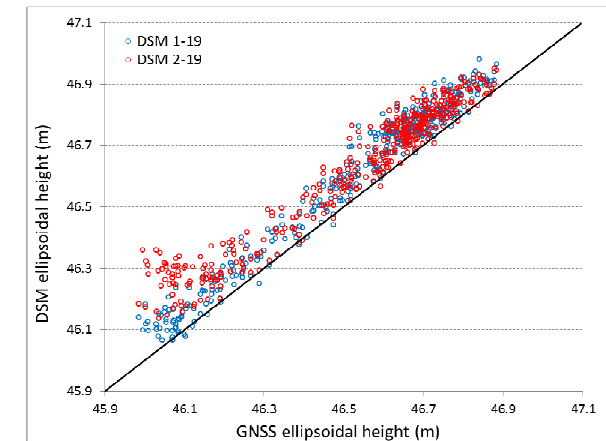
Figure 15. Scatter plot of ellipsoidal heights